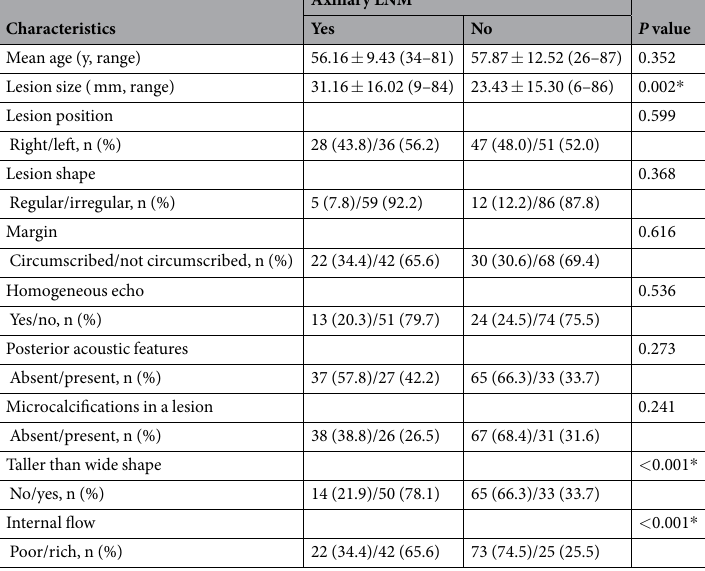
Table 1. Basic characteristics and ultrasound features of the patients. LNM lymph node metastasis. * Indicates statistically significant